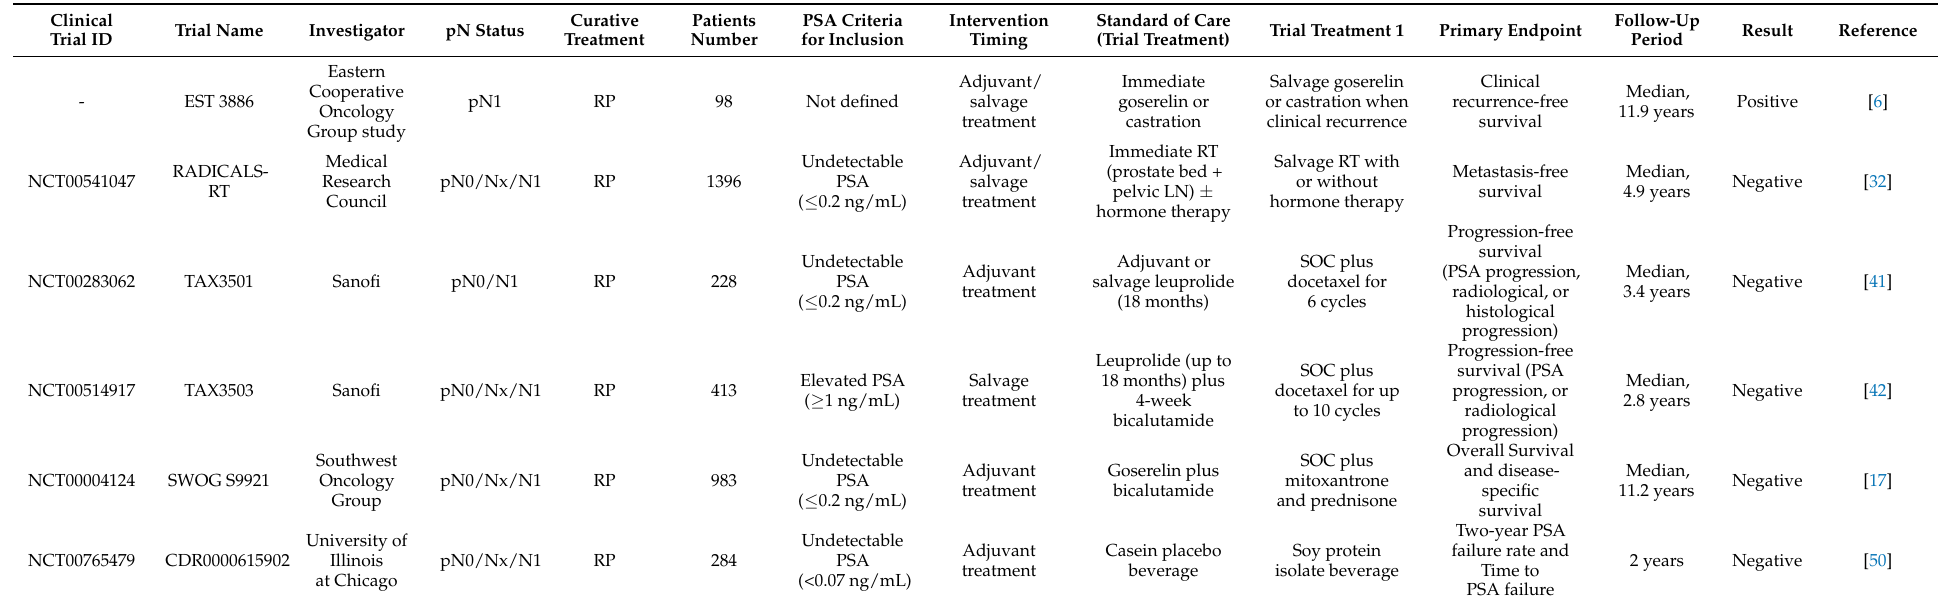
Table 3. Phase 3 randomized clinical trials for pN1 prostate cancer after